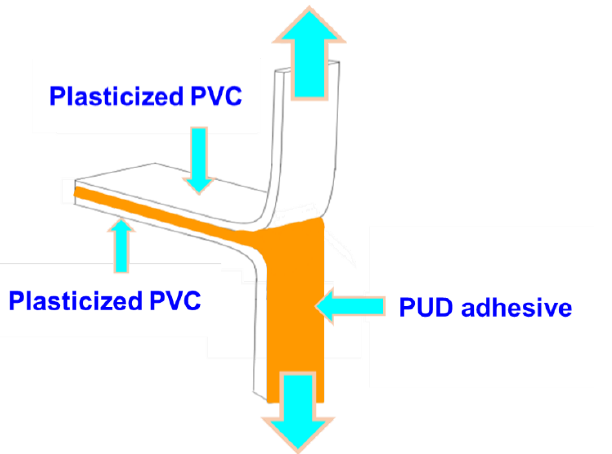
Figure 3. Scheme of the T-peel test of plasticized PVC/PUD adhesive/plasticized PVC joints.